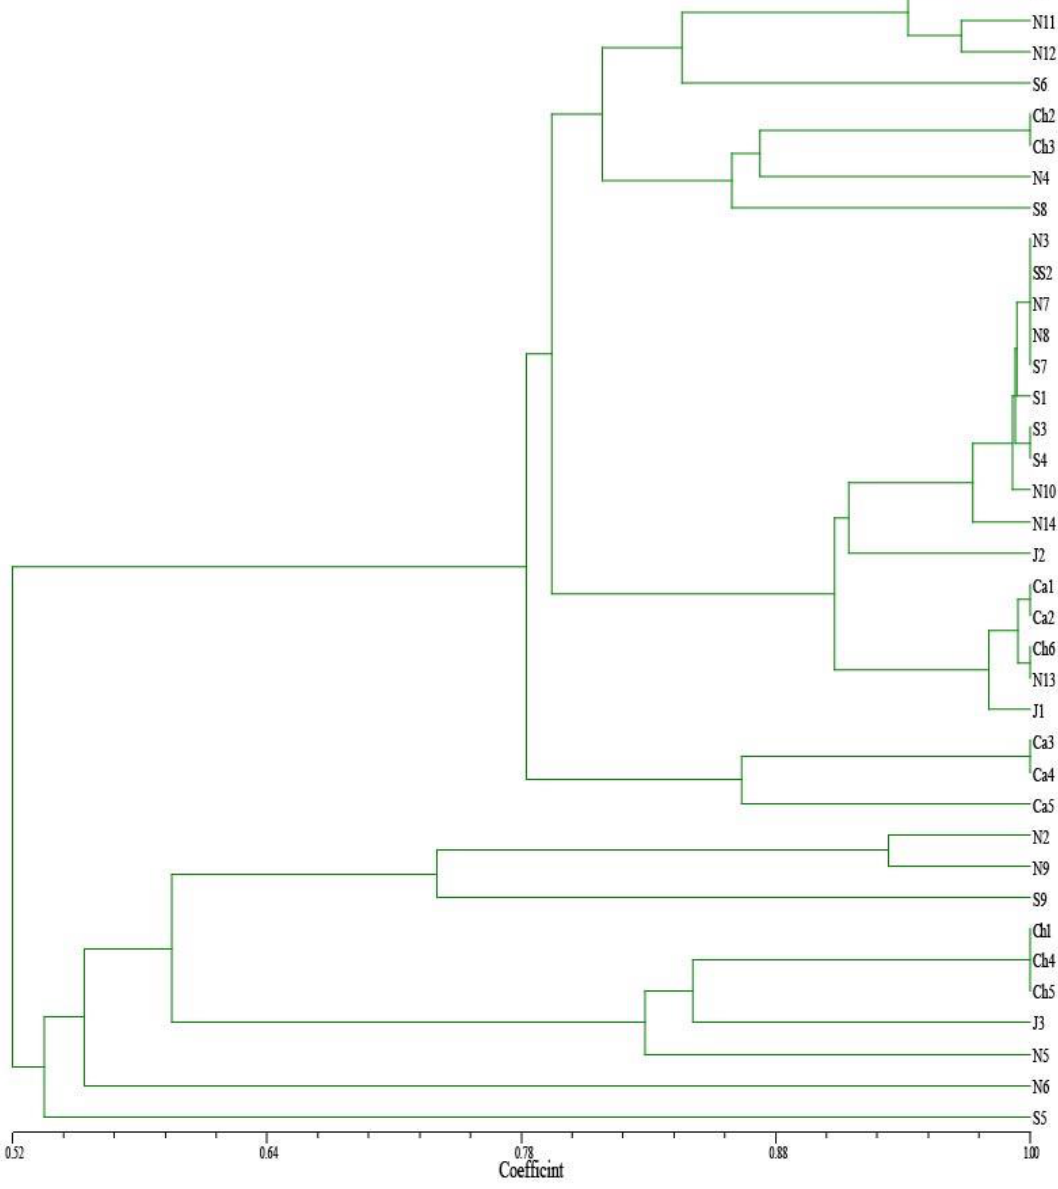
Figure 1. Dendrogram of isolates of Saprolegnia spp. as revealed by UPGMA cluster analysis of AFLP-based genetic similarity (Dice coefficient). The isolates are described by their geographic origin, as shown in Table 1.